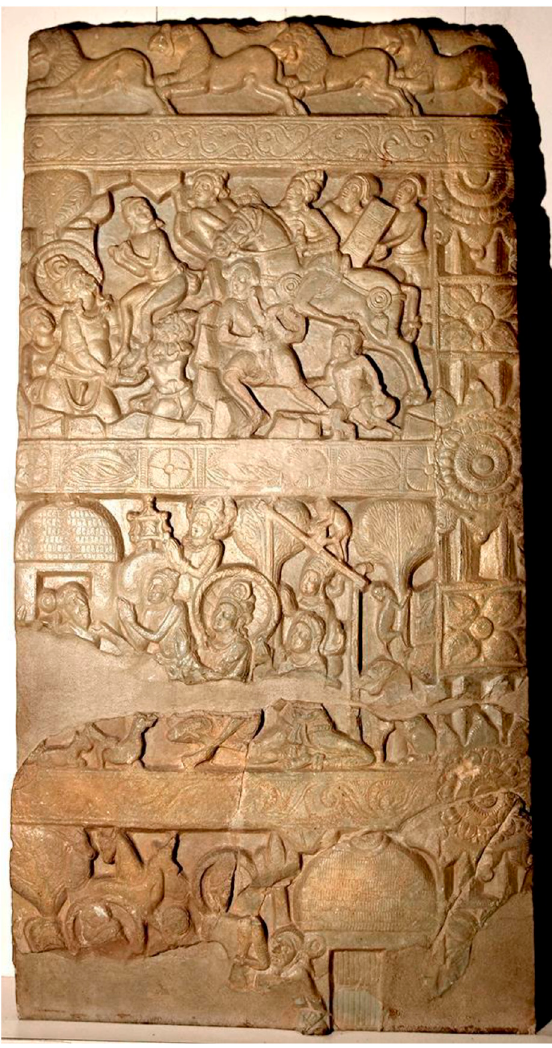
Figure 11. Nagarjunakonda, Archaeological Site Museum, no. 30 © photograph Wojtek Oczkowski with kind permission of ASI.